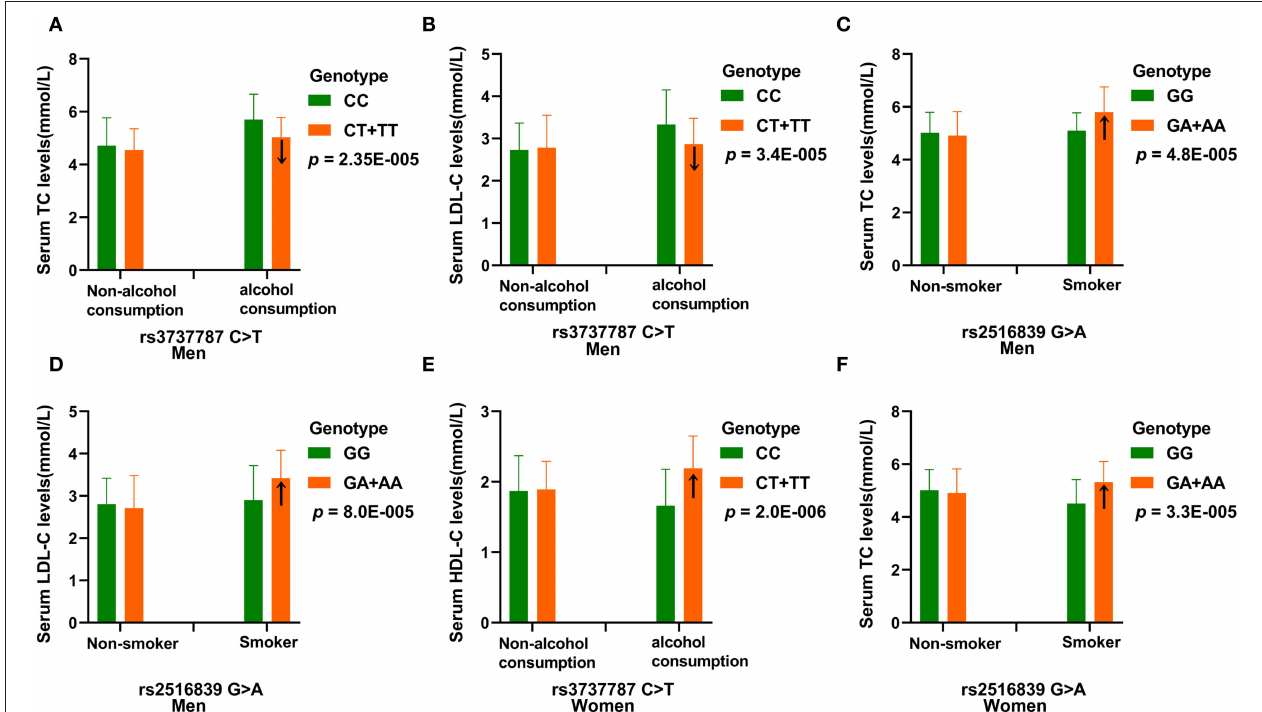
FIGURE 3 | The effect of rs3737787-alcohol consumption and rs2516839-smoking interactions on serum lipid levels. (A) Effect of the rs3737787-alcohol consumption interaction on TC levels in men. (B) Effect of the rs3737787-alcohol consumption interaction on LDL-C levels in men. (C) Effect of the rs2516839-smoking interaction on TC levels in men. (D) Effect of the rs2516839-smoking interaction on LDL-C levels in men. (E) Effect of the rs3737787-alcohol consumption interaction on HDL-C levels in women. (F) Effect of the rs2516839-smoking interaction on TC levels in women. TC, total cholesterol; LDL-C, low-density